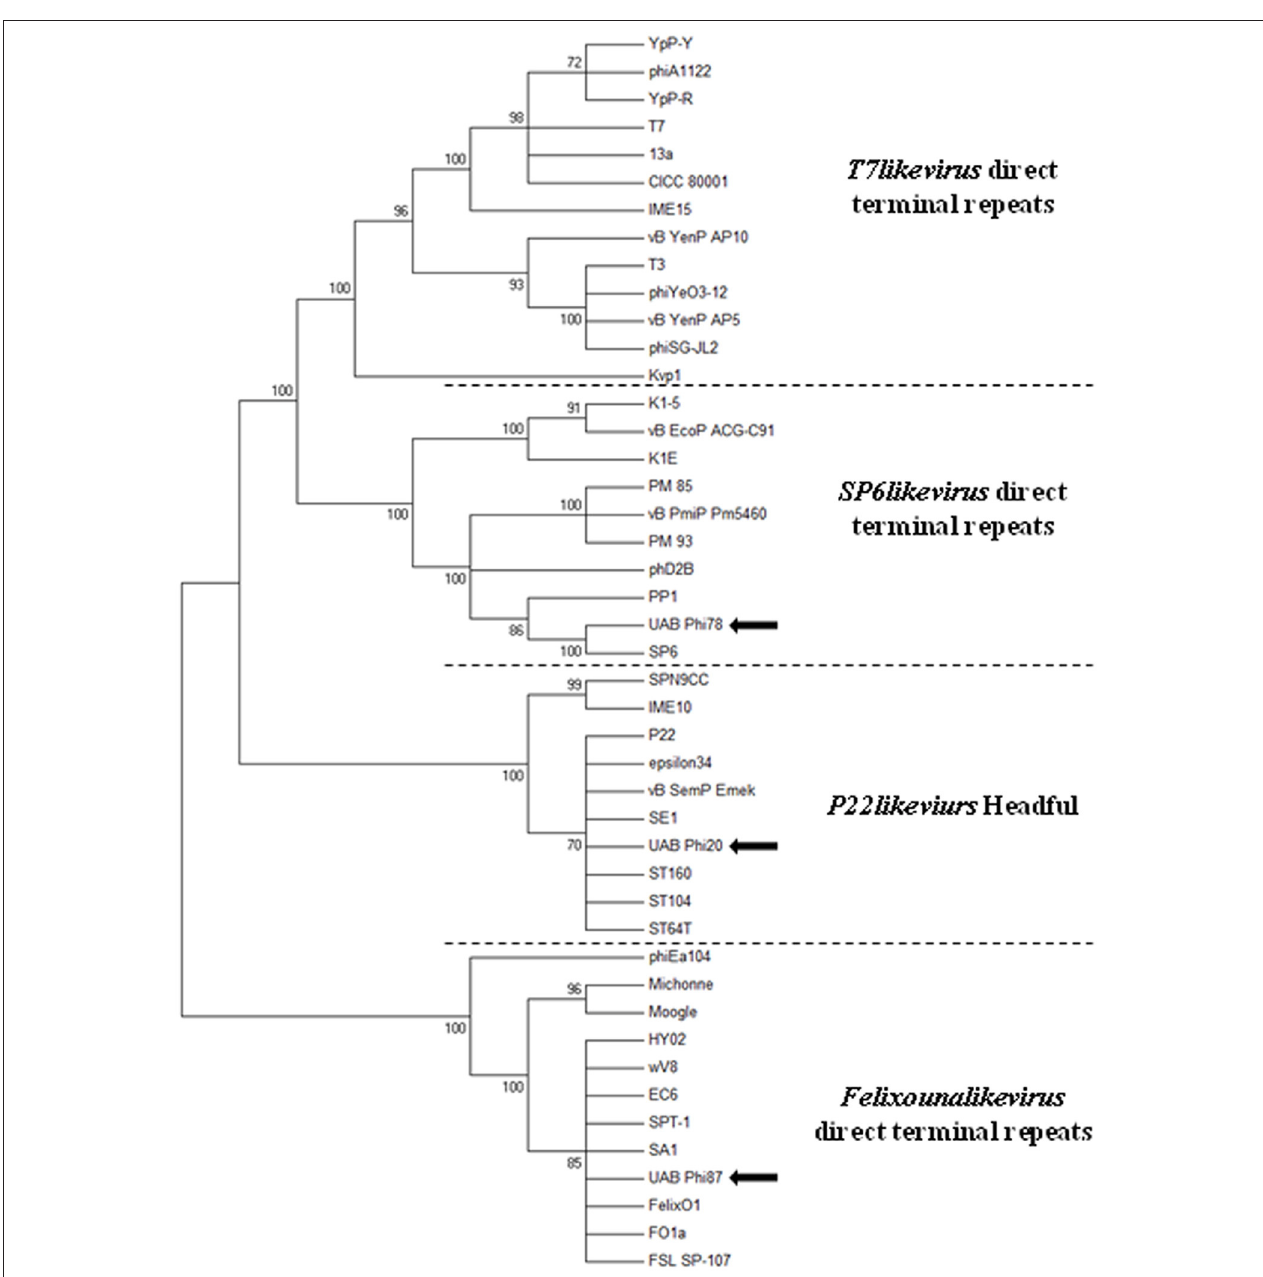
FIGURE 7 | Neighbor-joining phylogenetic tree of large terminase subunit sequences of bacteriophages UAB_Phi20, UAB_Phi78, and UAB_Phi87 (indicated by arrows) and comparison to other phages with known packaging mechanisms. Bootstrap analysis was performed with 1000 repetitions. The node of phylogenetic tree shows the bootstrap confidence values above